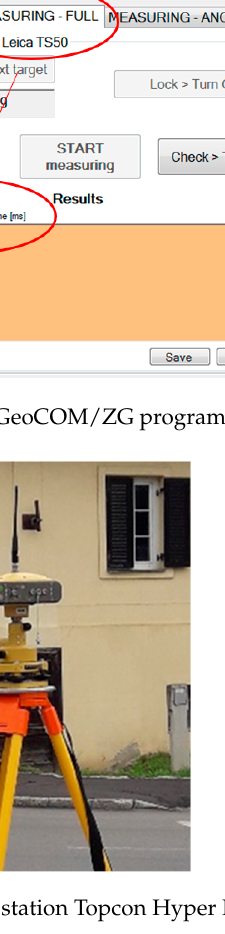
Figure 4. Base station Topcon Hyper Pro.